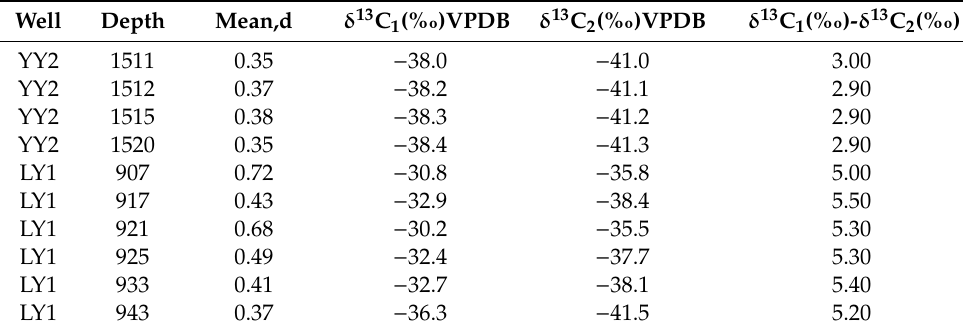
Table 3. Characteristics of microcrystalline mean diameters and the value of δ 13 C. Well Depth Mean,d